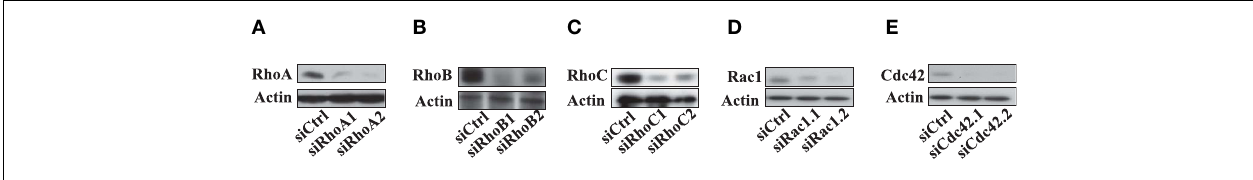
FIGUREA3 | Decrease of Rho proteins expression in LB1319-MEL cells transfected withRho specific siRNAs. The efficiency in decreasing Rho protein expression of Rho specific siRNAs transfections were analyzed by